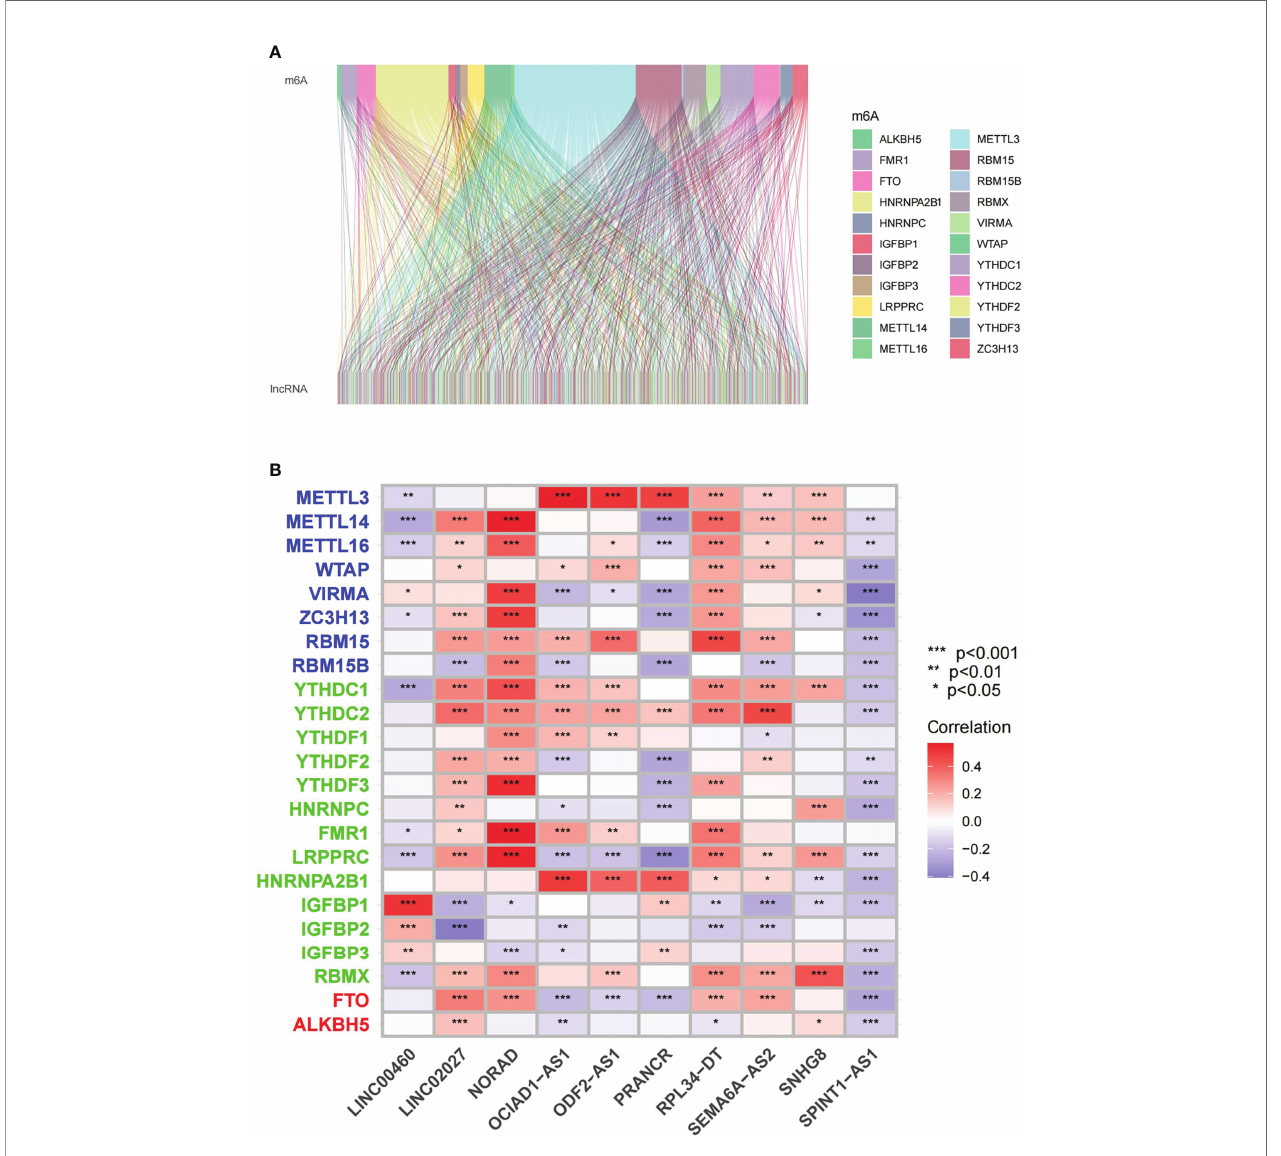
FIGURE 2 | Identi fi cation of m6A-related lncRNAs in KIRC patients (A) Sankey relational diagram for 23 m6A genes and m6A-related lncRNAs. (B) Heatmap for the correlation between 23 m6A genes and the 10 prognostic m6A-related lncRNAs. *p < 0.05, **p < 0.01, ***p <